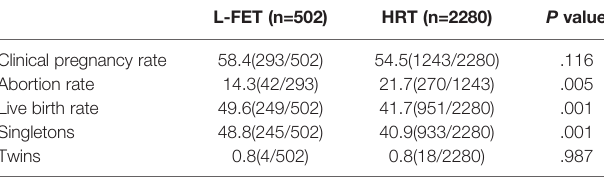
TABLE 2 | Comparison of pregnancy outcome between the two